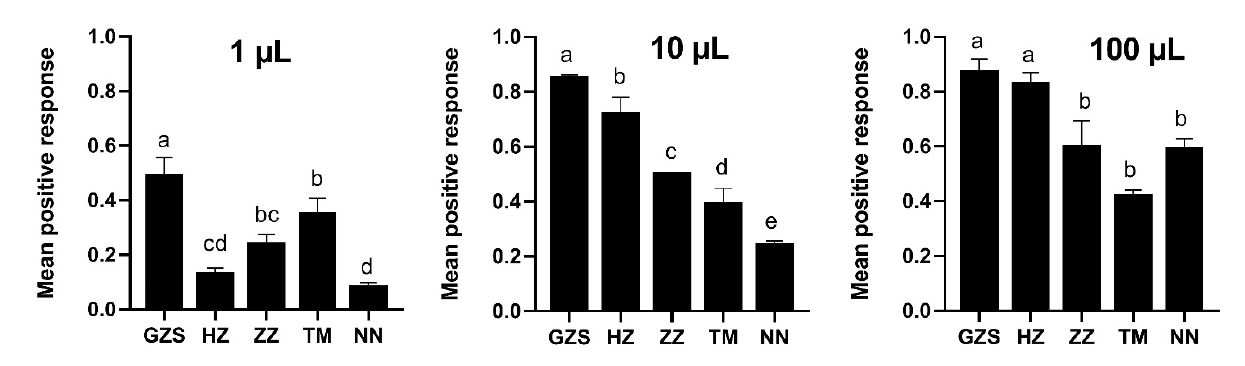
Figure 1. The response of B. dorsalis males from the GZS ‐ susceptible strain and the four field populations to ME. The assay was conducted by using three doses of ME (1, 10, 100 µL) and MO alone served as controls accordingly in trap cages (30 × 30 ×30 cm 3 ) for 6 h. No flies were trapped in the control MO cages. Data are presented as the mean ± SE. Different letters on the histogram bars indicate significant differences based on one ‐ way ANOVA followed by Tukey’s HSD multiple com ‐ parison test ( p < 0.05).